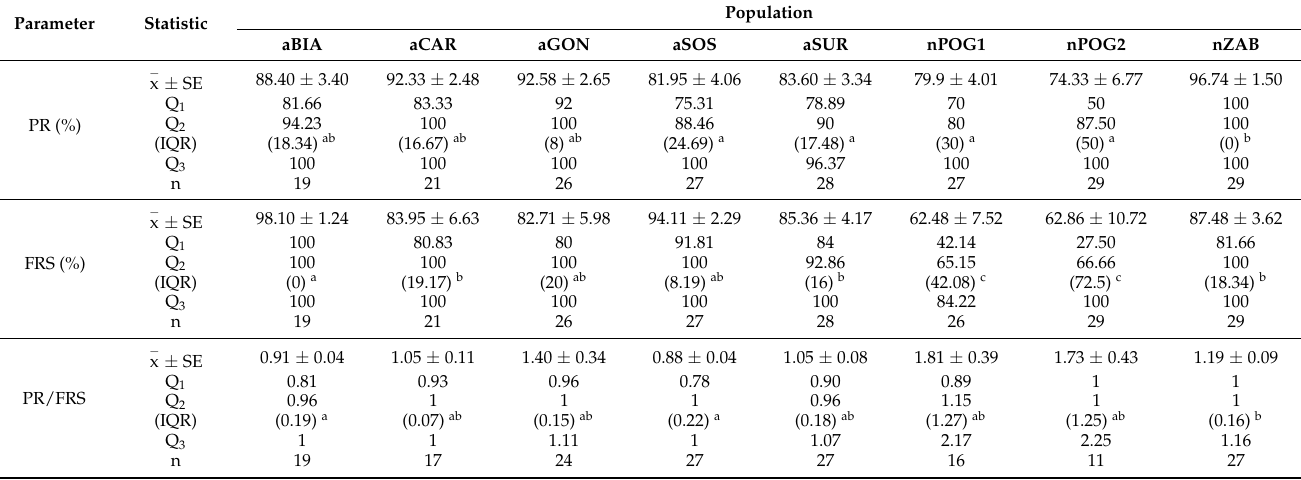
Table 5. Spatial variation in pollinaria removal (PR) and female reproductive success (FRS) in the natural and anthropogenic populations of Epipactis helleborine. Data represent the mean (x) ± standard error (SE), lower quartile (Q 1 ), median (Q 2 ), upper quartile (Q 3 ), interquartile range (IQR), and biological replicate (n). Different letters indicate statistically significant differences according to the pairwise Wilcoxon rank sum test with the Benjamini–Hochberg adjustment ( p < 0.05).